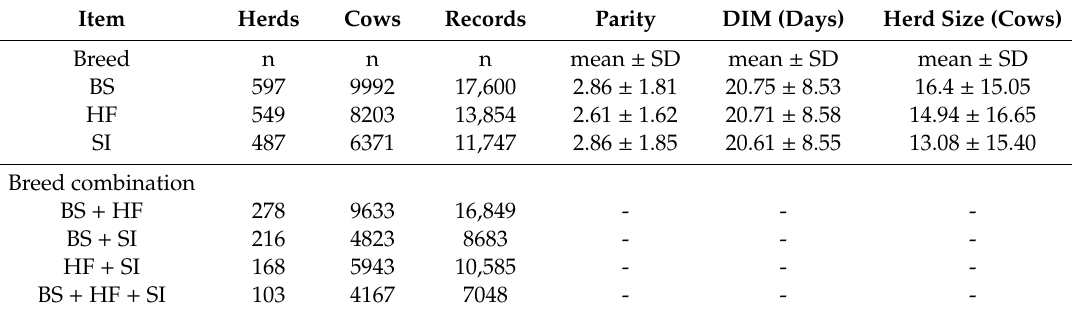
Table 1. Number of herds, cows, and records by breed and breed combination, and descriptive statistics of parity, DIM, and herd size by breed. Breeds are: Brown Swiss (BS), Holstein-Friesian (HF), and Simmental